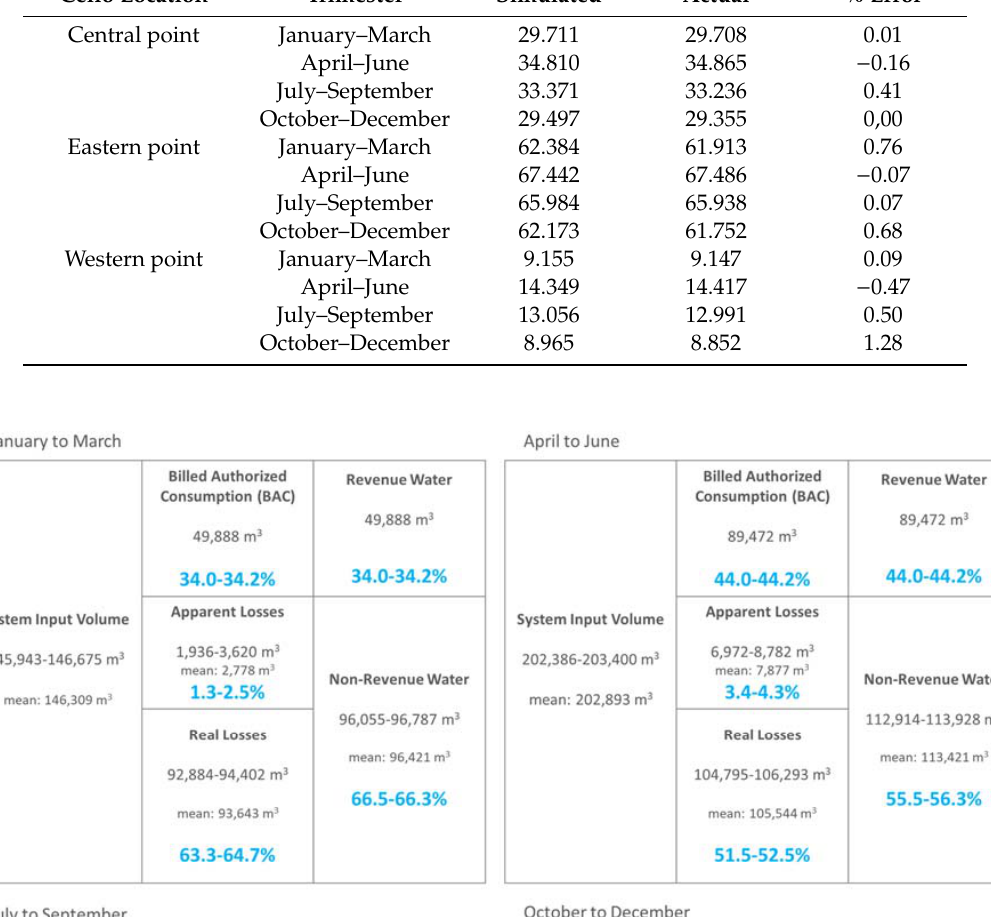
Table 3. Simulated and actual trimester-average pressure values in m for the three cello points. Cello Location Trimester Simulated Actual % Error Central point